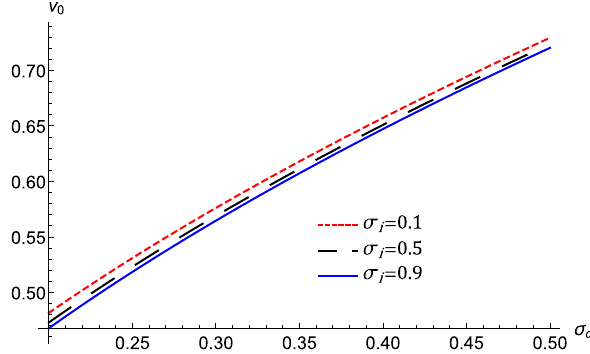
Figure 1. The variation of the phase speed v 0 , represented by Eq. (5) against σ d for different values of σ i at µ e = 18